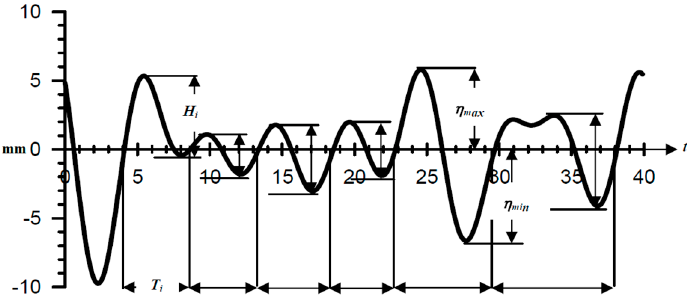
Figure 4. Show of the zero up-cross method [30]. H, The wave high; n max : The average value of the highest point (peak).